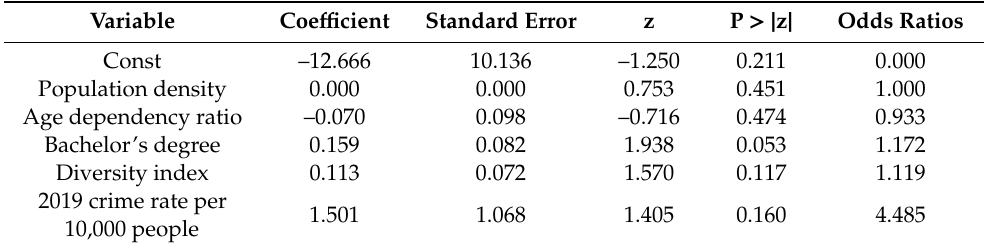
Table 5. Regression results for change rate of